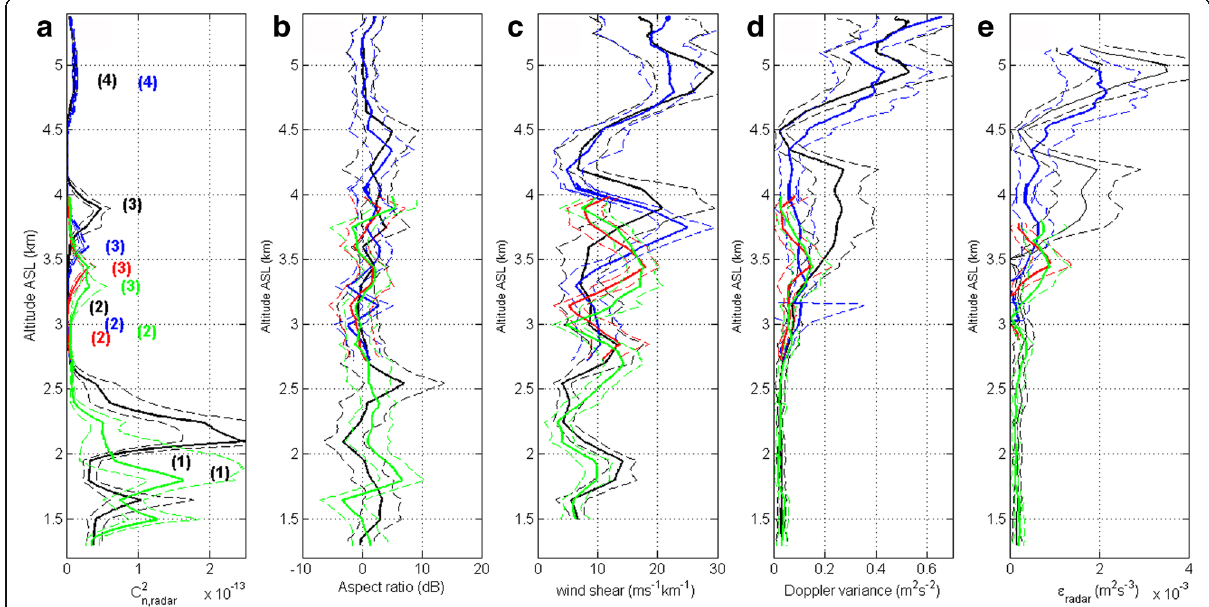
Fig. 9 a – e Vertical profiles of parameters estimated from the MU radar measurements during UAV 17. The leftmost panel shows C 2 rightmost panel shows ε radar using Eq. (3). The labels (1) to (4) shown in the leftmost panel refer to altitude ranges indicated in Figs. 5b and 8. The black curve corresponds to A1, blue to D1, red to A2, and green to D2 (see Fig.